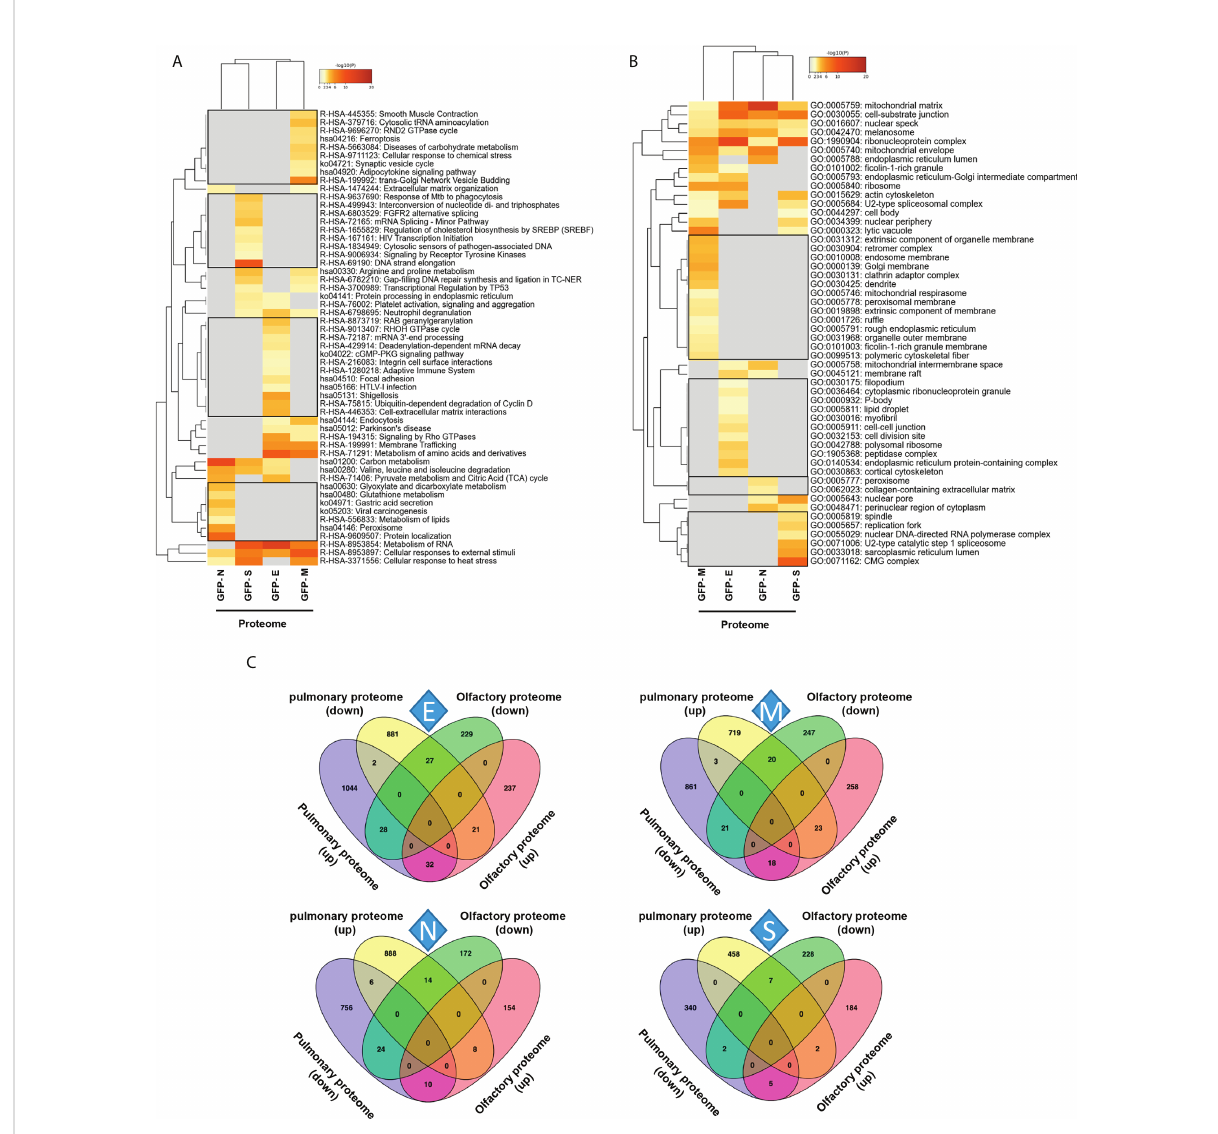
FIGURE 3 Functional clustering based on the speci fi c OBC1 proteome disrupted by each SARS-CoV-2 structural protein. (A) Reactome-based pathway enriched clusters across diferential proteomes induced by the expression of GFP-SARS-CoV-2 structural proteins. (B) GO ontology clustering focus on subcellular compartments. Squares (black frame) represent signi fi cantly enriched terms derived from the independent expression of each SARS-CoV-2 structural protein. (C) Commonalities and differences between proteostatic changes induced by the expression of SARS- CoV-2 structural proteins in olfactory OBC1 and pulmonary A549 cells